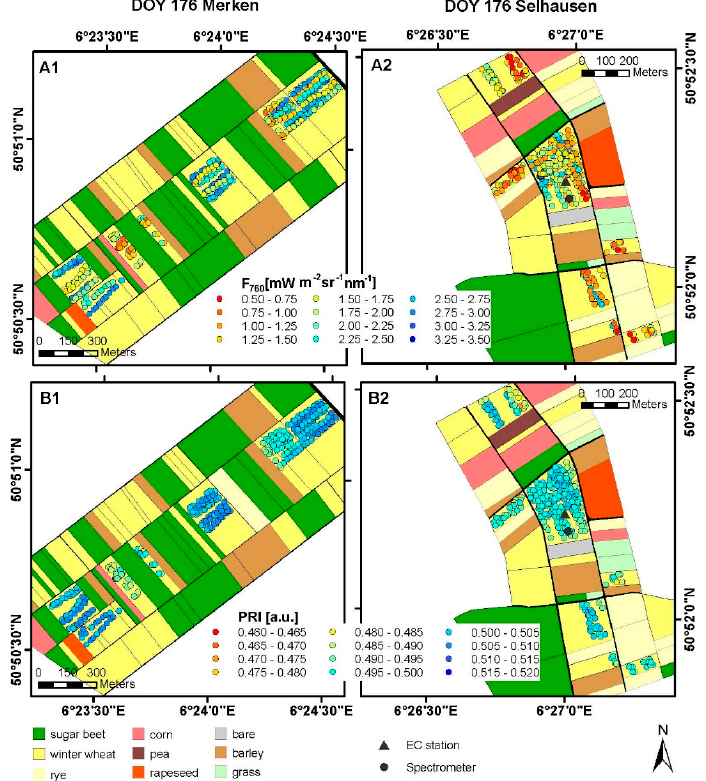
Figure 2. Airborne based F 760 and PRI measurements acquired on DOY 176 (24 June 2008) over winter wheat (colored circles) superimposed over a land cover map. Left column: fields close to Merken. Right column: fields close to Selhausen. Top row ( A1 , A2 ): Sun-induced chlorophyll fluorescence at 760 nm (F 760 ). Bottom row ( B1 , B2 ): Photochemical reflectance index (PRI). Black triangle and dot mark the location of the ground observations.